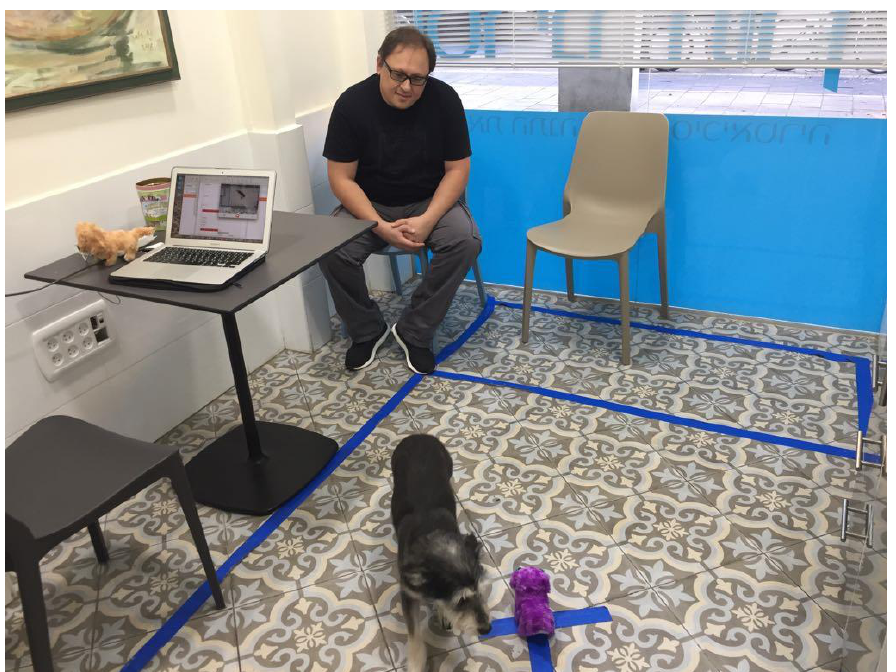
Figure 3 . Owner and dog in Tel Aviv clinic.